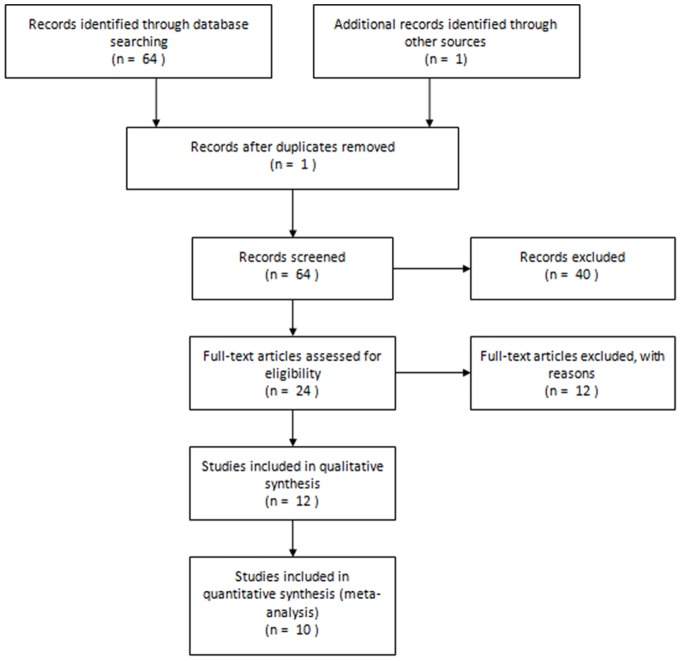
Flowchart of literature search and selection.A total of 14 studies from 10 published articles were identified in this meta-analysis.